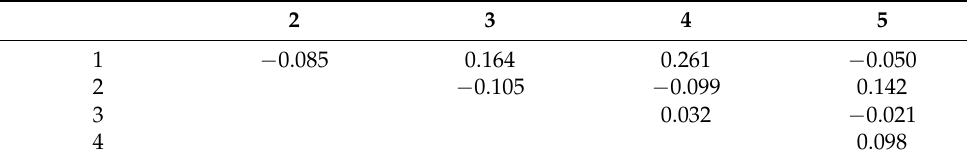
Table 2. Correlations.